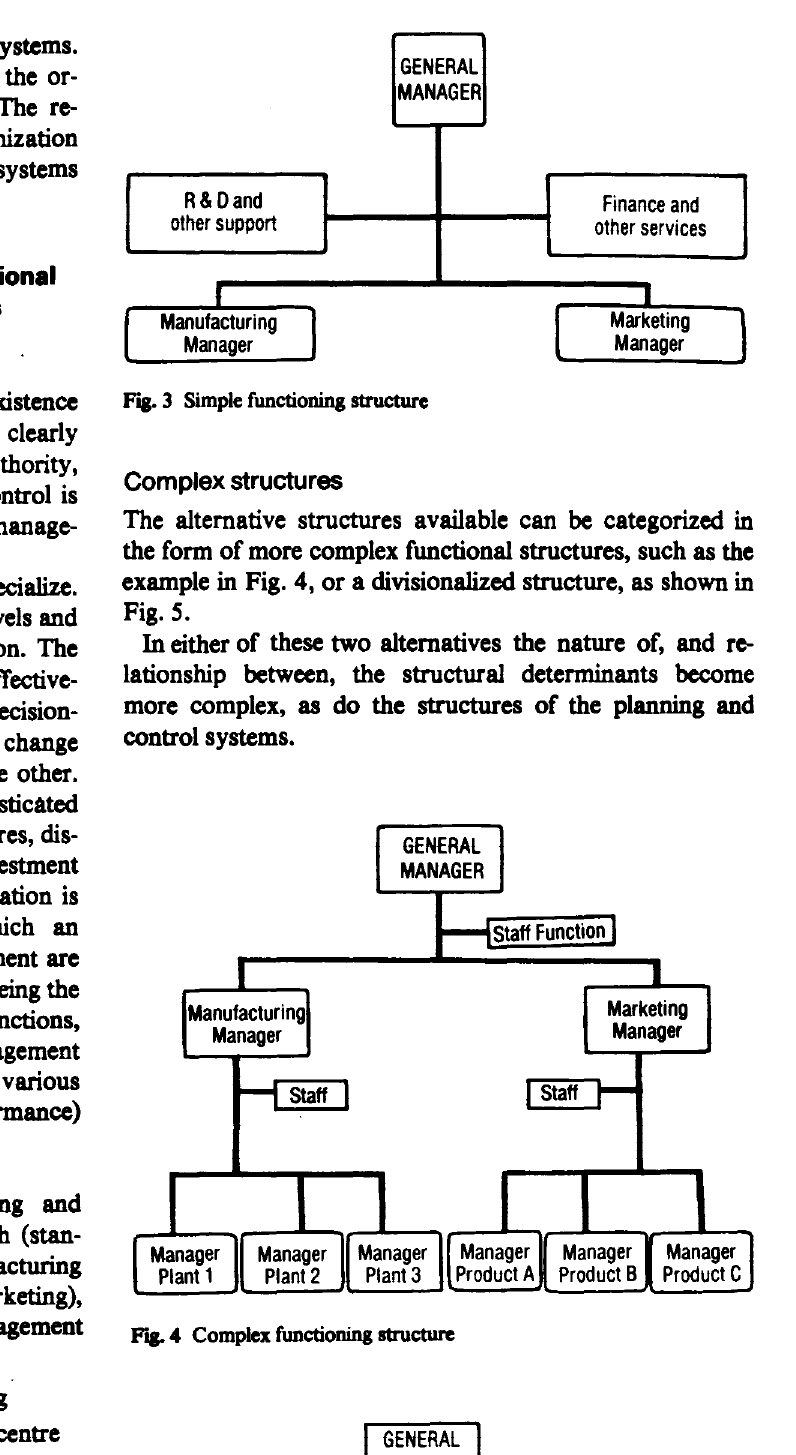
Fig. 4 Complex functioning structure